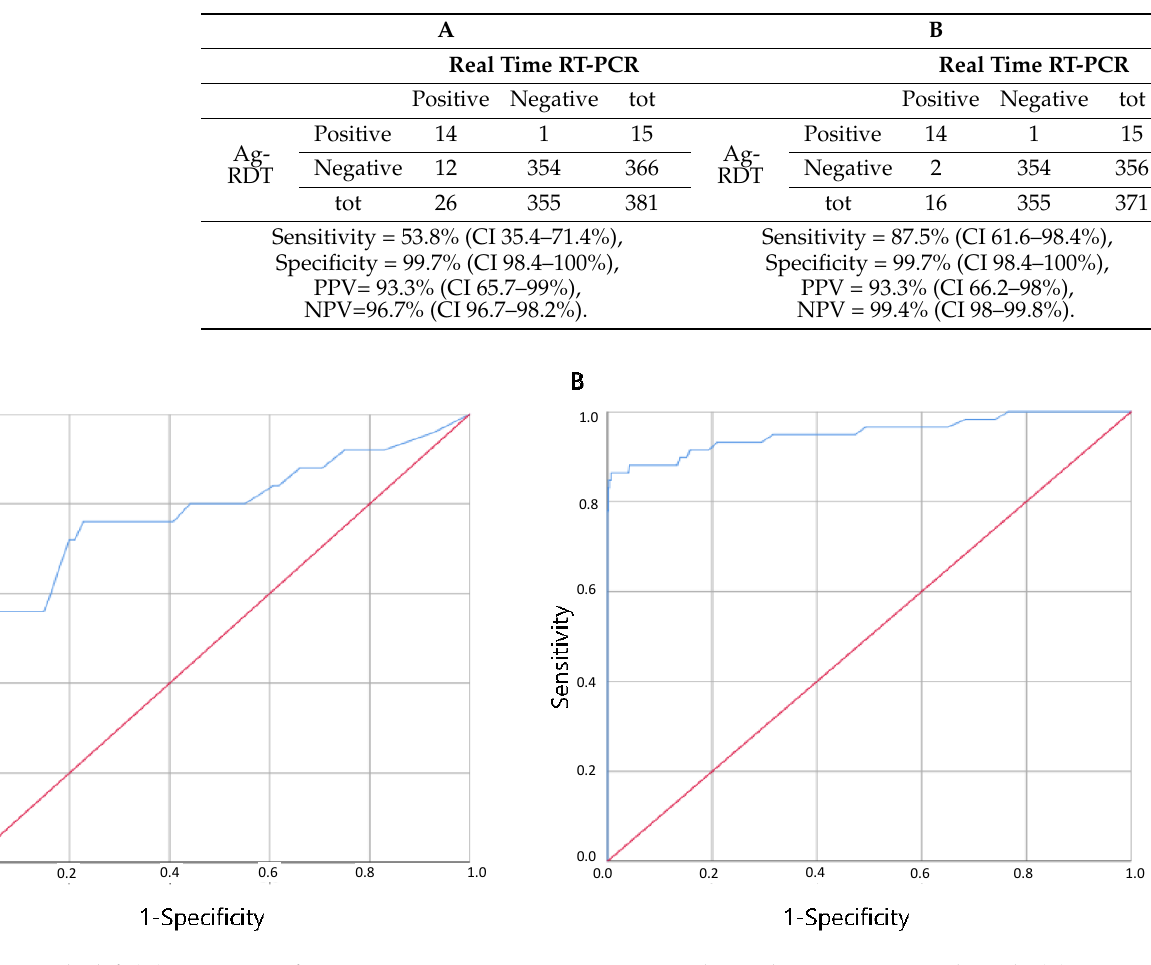
Figure 1. On the left ( A ), ROC curve for COVID-19 Ag FIA Ag-RDT, compared to real time RT-PCR on the right ( B ), ROC curve for AFIAS COVID-19 Ag compared to real time RT-PCR. On the x axis, 1-specificity; on y axis, sensitivity.